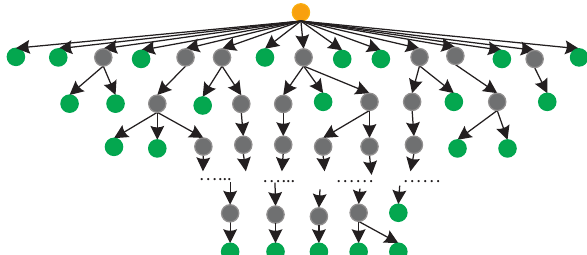
Figure 1: Example of an IPT. The yellow root node is the user who posted the original message. Gray nodes are users who spread the information (propagation nodes) and green nodes indicate users who did not spread the information (terminal nodes) [20]. The directed arrows show information flows. Hence, an IPT is also a subgraph of the social networks formed by users, i.e., one of the subgraphs of the user’s circle of